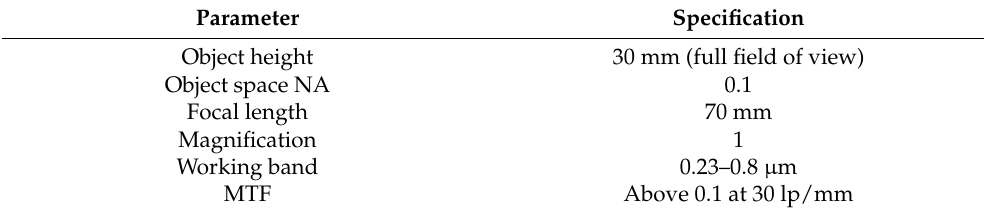
Table 1. Design parameters of the lens